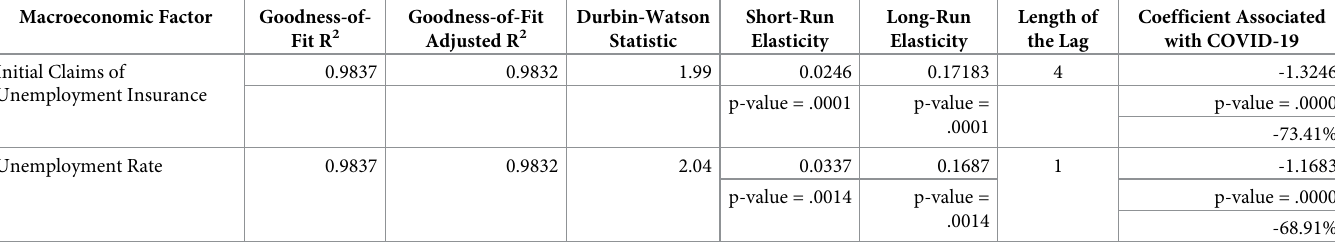
Table 8. Key metrics of the econometric distributed lag models concerning NSLP participation by macroeconomic